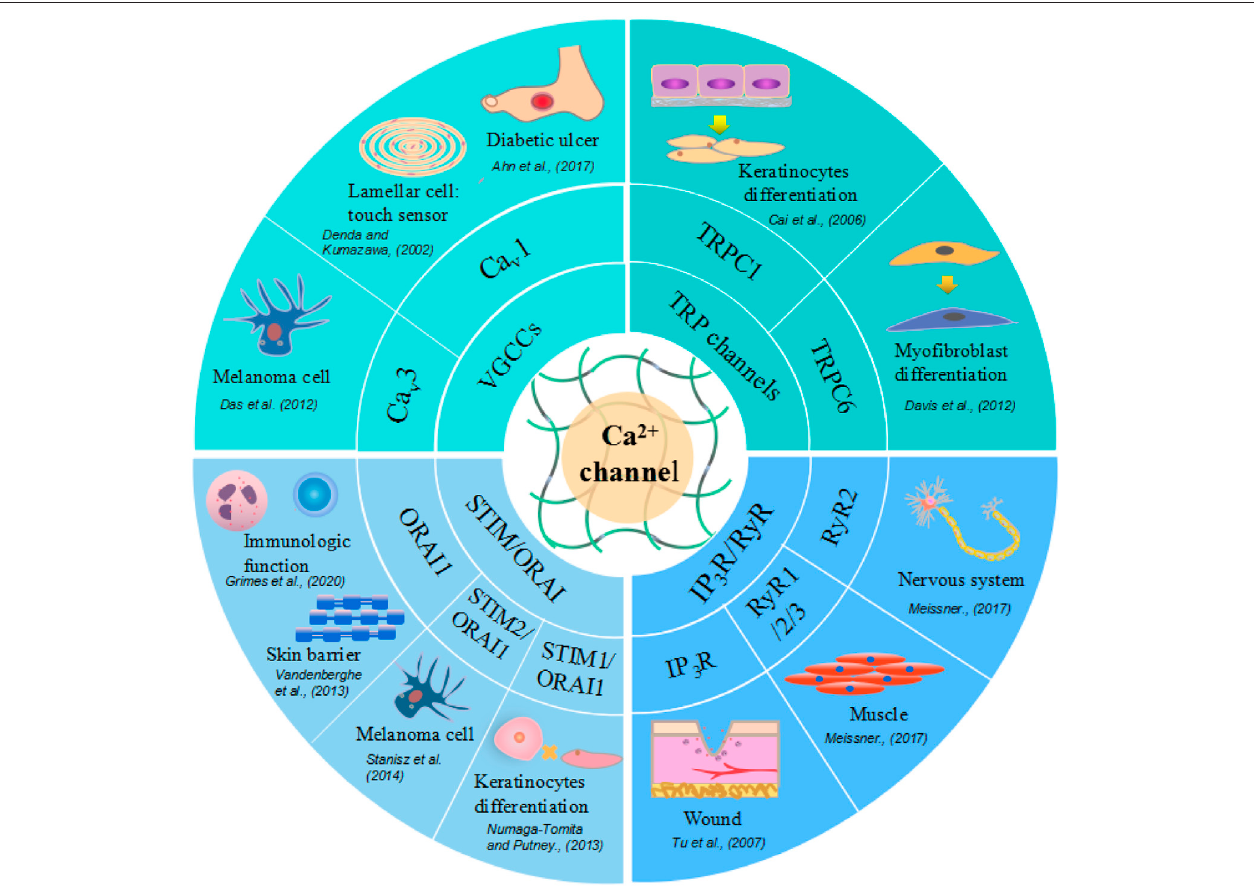
FIGURE3| Differentcalciumionchannelsandrelatedskincellsandphysiologicalfunction.Voltage-GatedCalcium(Ca v )Channelsarelamellarcelltouchsensorsof skin, with increased expression in melanoma cells and decreased in diabeticulcer. TRPchannels facilitate keratinocytes and myo fi broblastdifferentiation. STIM or ORAI promote keratinocytes proliferation, skinbarrierformationand regulateimmunologicfunction. Ryanodinereceptors expressinnervoussystem, muscle,braintissueand also function in wound healing.